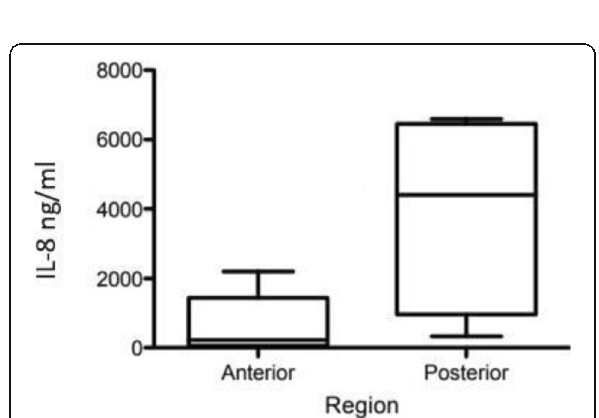
Fig. 3 (abstract 0274). Concentration of interleukin-8 (BAL) in the anterior and posterior regions of the